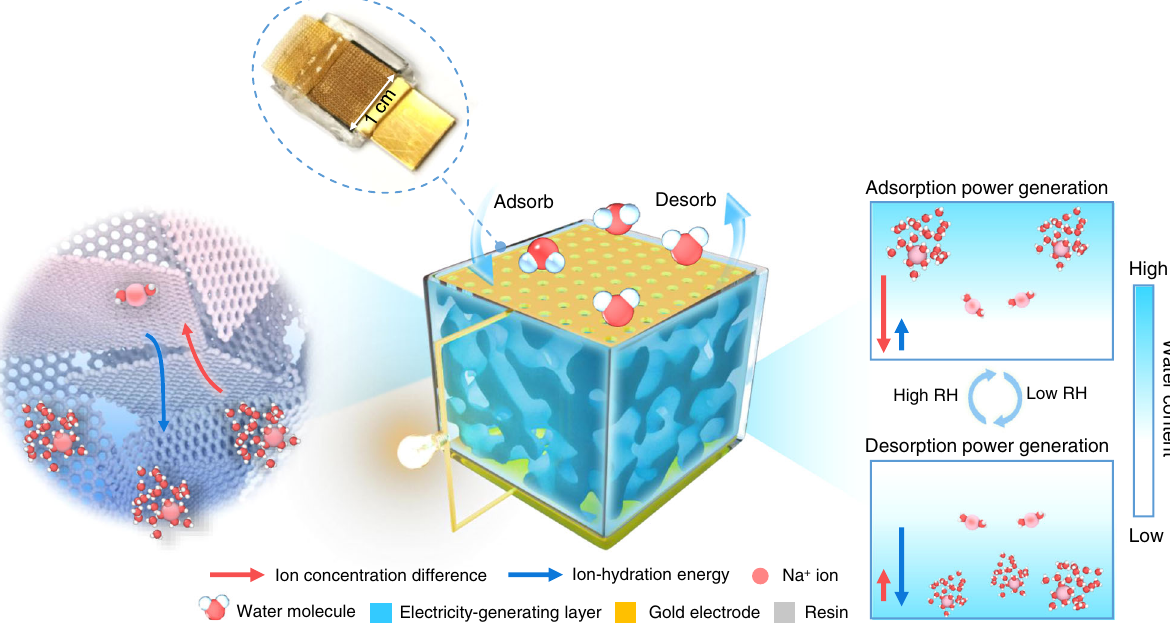
Fig. 1 Design of MADG. Scheme of the device structure, working principle, and photograph of device. The MADG is composed of gold electrodes, 3D ionizable porous assembly as electricity-generating material, and encapsulation layer, where the upper gold electrode has holes to allow entry/removal of moisture. Bene fi ting from well-designed structure, the MADG enables to deliver electric output under high and low RH condition through asymmetric moisture adsorption and desorption process, respectively. The electricity-generating principle is attributed to hydrated ions diffusion, driven by ion concentration difference during moisture adsorption power generation and dominated by ion-hydration energy during moisture desorption electricity generation,